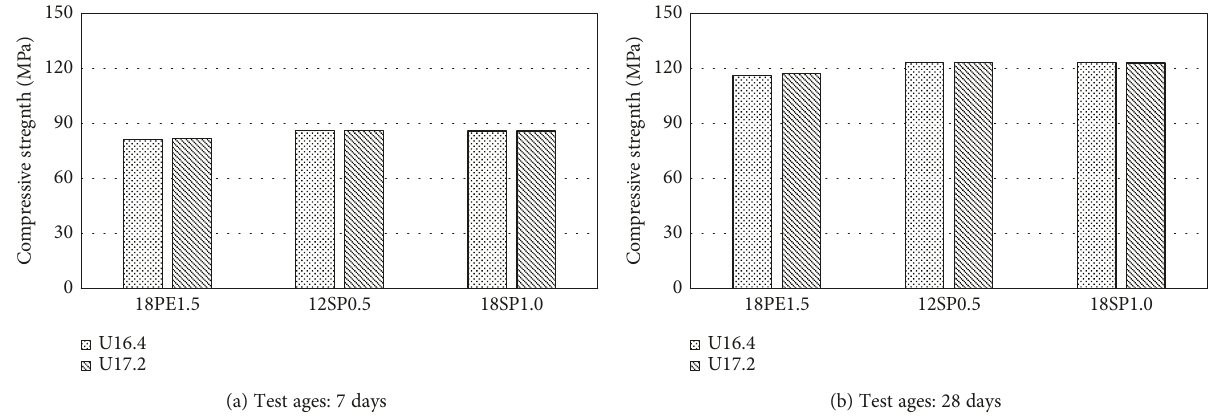
Figure 3: Compressive strength of hybrid fi bers reinforced